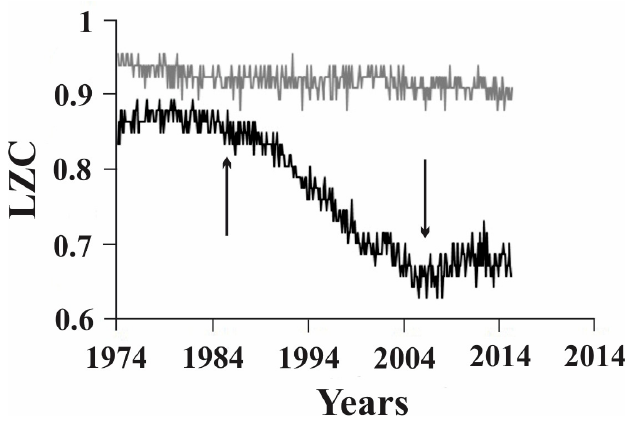
Figure 10. Lempel and Ziv complexity measure calculated for (M2.2 threshold) around the Enguri reservoir (R = 100 km) 1974–2017 using 500 data windows shifted by one data. Magnitudes sequence (grey) and interevent sequence